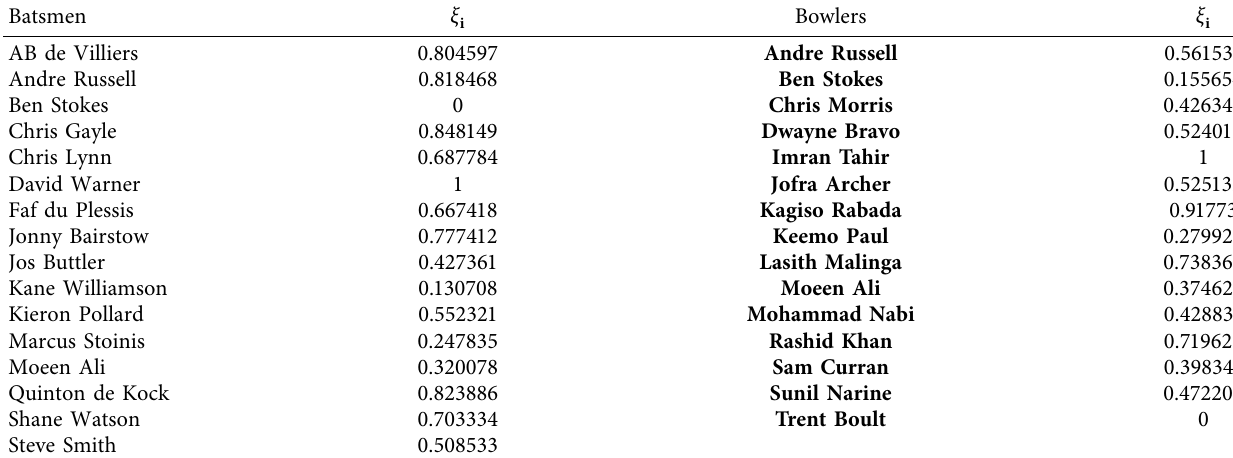
Table 10: ξ i for batsmen and bowlers.